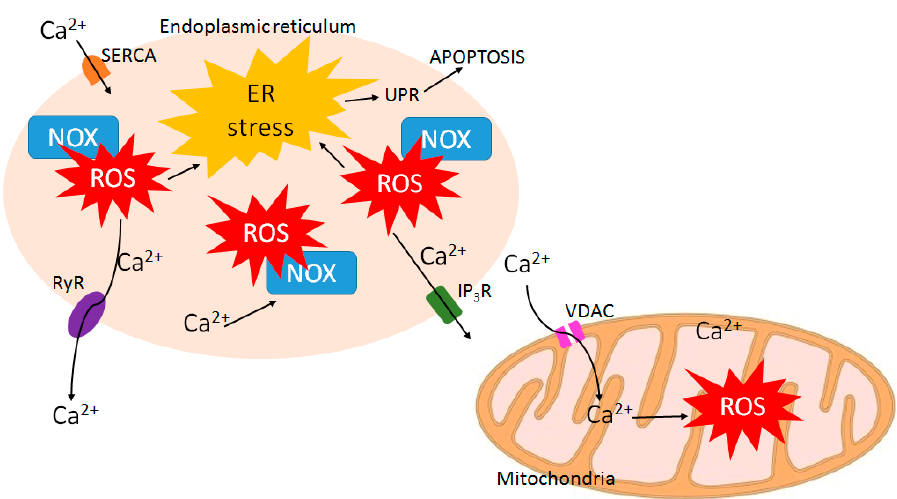
Figure 4. Calcium-ROS connection in controlling ER-mitochondria cross-talk. ER-resident